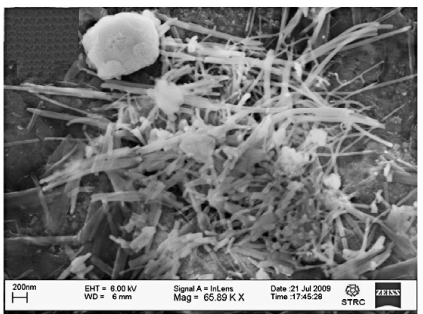
Figure 3. CNTs agglomeration in 5 wt % CNT-Al blends processed by mechanical milling for 30 min [38]. (Adapted with permission from [38], Elsevier, 2011.)